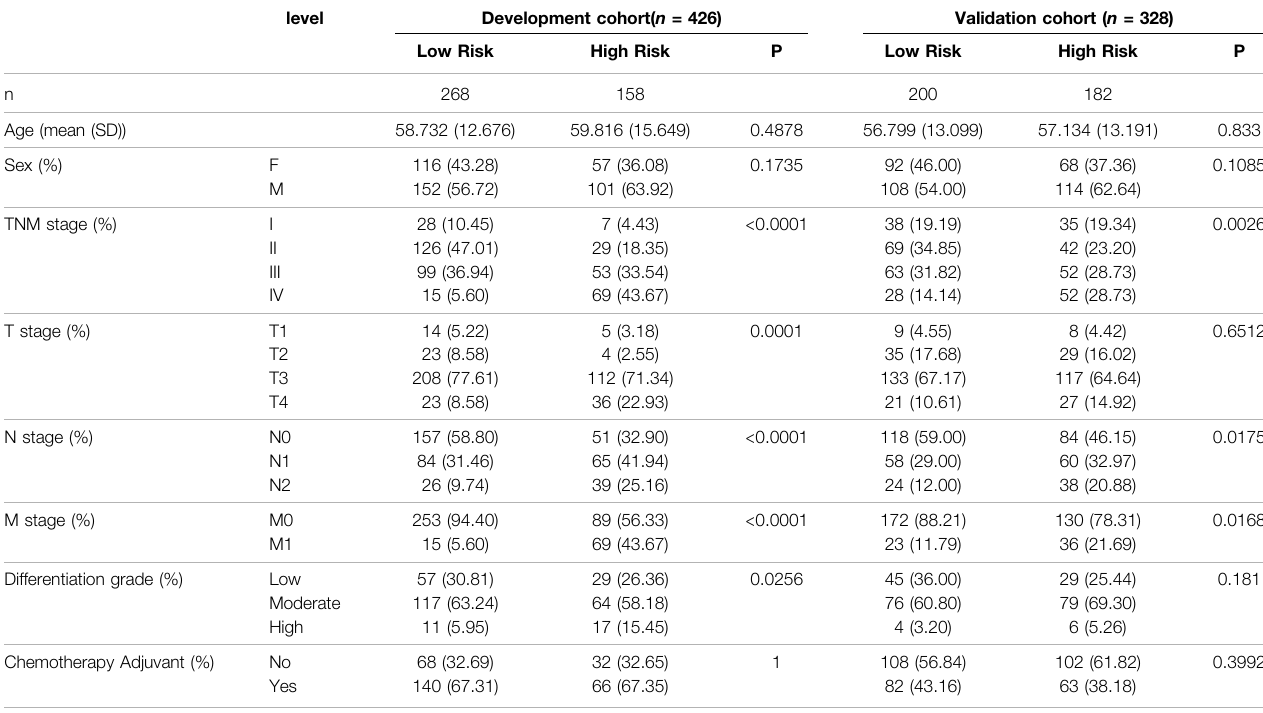
TABLE 1 | Baseline characteristic of patients in the development and validation